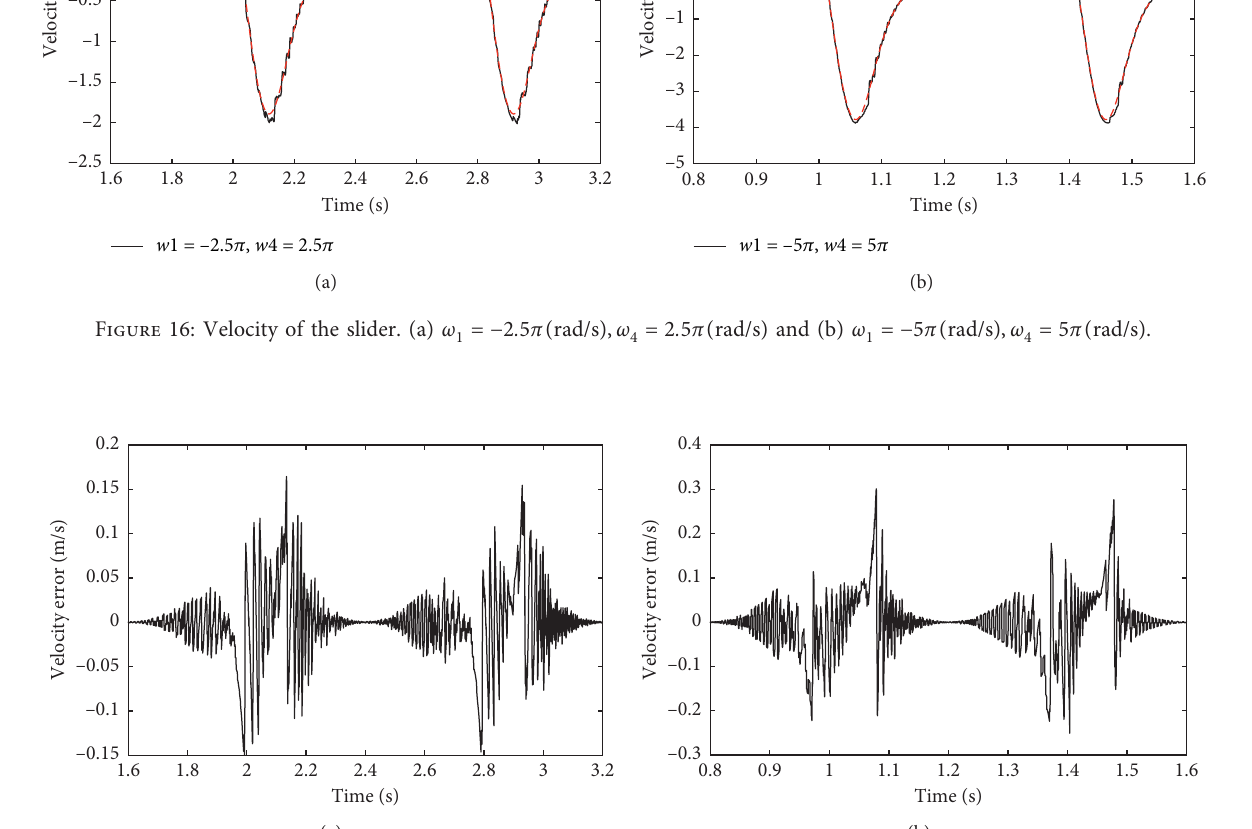
� − 2 . 5 π ( rad/s ) , ω 1